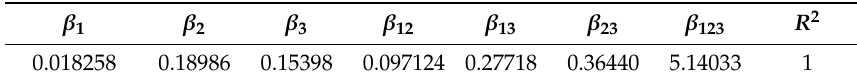
Table 4. Calculated parameters of the special cubic model using the Clark model for the mixtures of MgO nanoparticles and CTAB evaluated in system